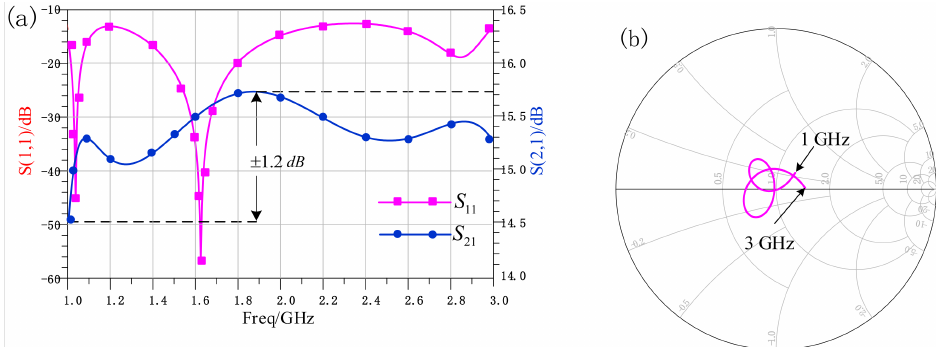
Figure 12. S-parameter simulation results of the proposed PA. ( a ) S-parameter simulation results; ( b ) The Impedance track of the proposed PA.